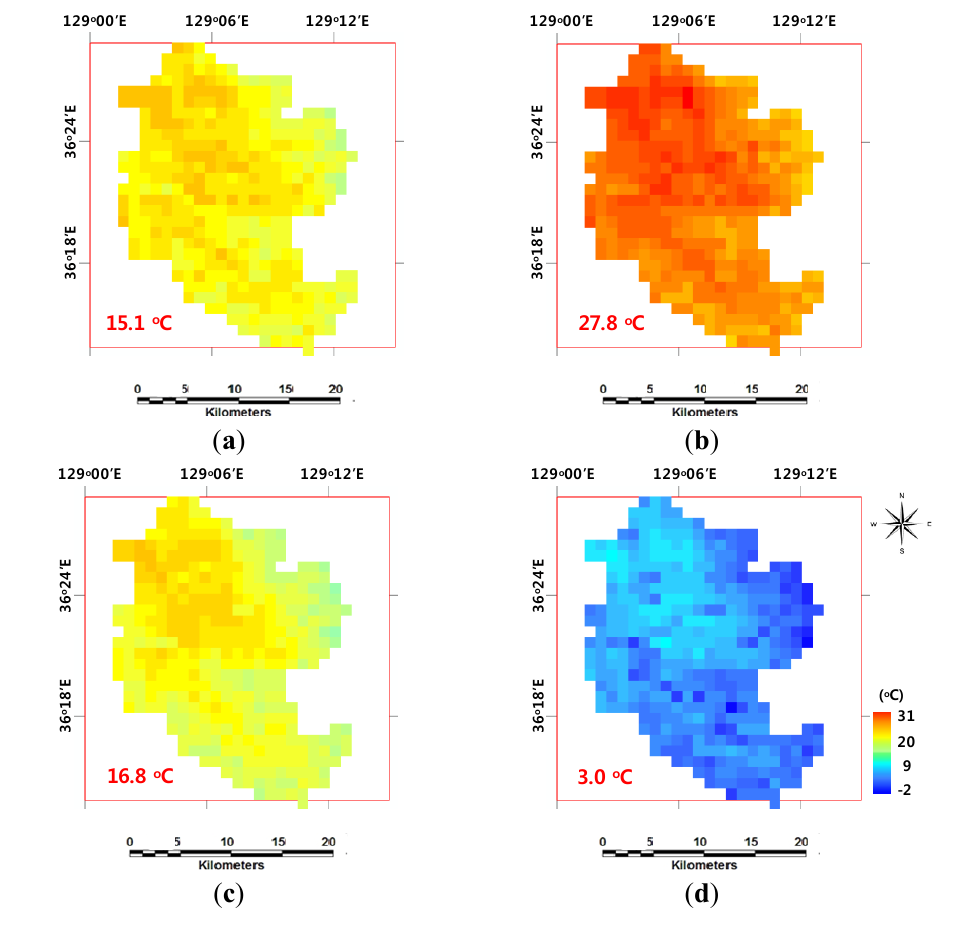
Figure 7. Spatial distributions of 1-km grids and representative values of a 30-km grid (red box and value) for the seasonal average of land surface temperatures simulated from